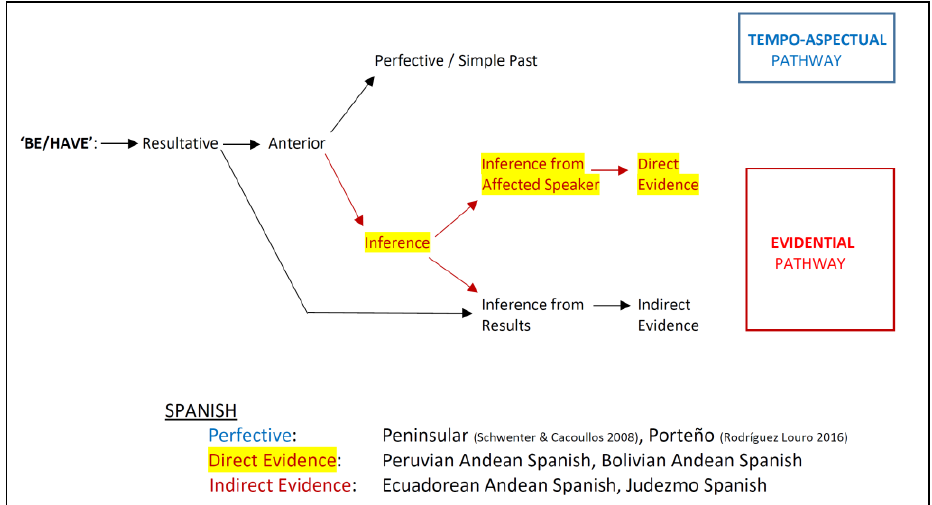
Figure 9 . Proposal for revision of the Bybee et al. (1994) evidential pathway : Andean Spanish Present